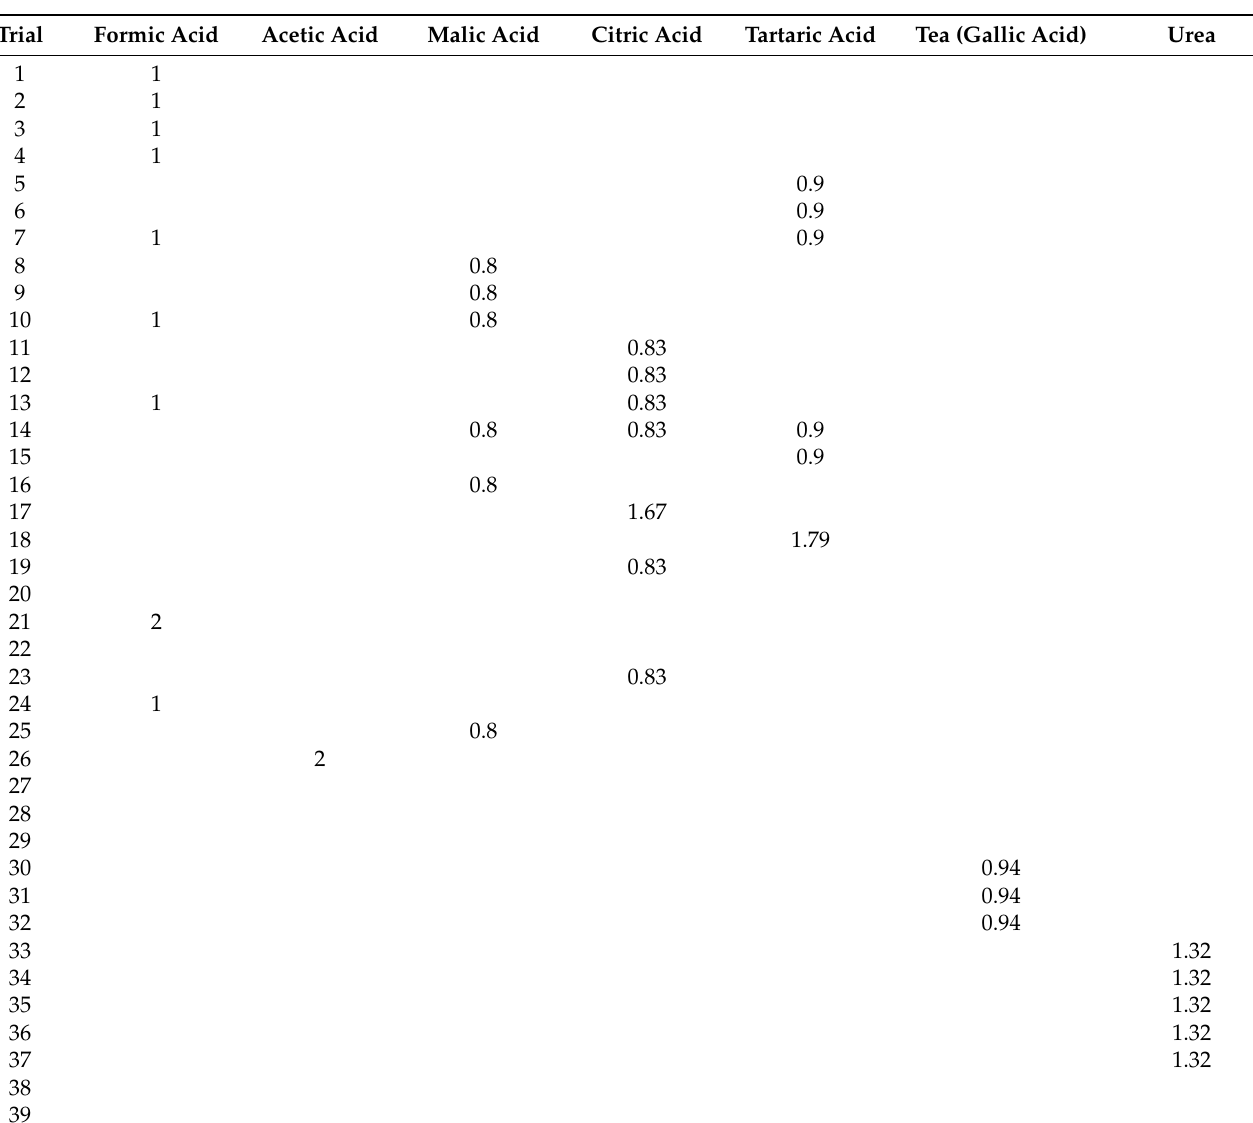
Table A4. Organic Polymer Ingredients: powders = g L − 1 ; Formic acid = 40%, cm 3 L − 1 ; Acetic acid